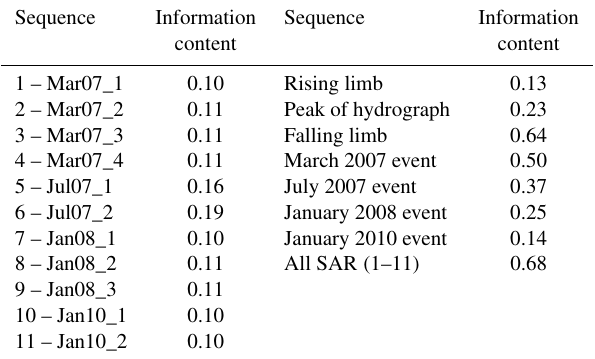
Table 5. Information content for r from SAR observations and groups of SAR observations with a 90% confidence limit